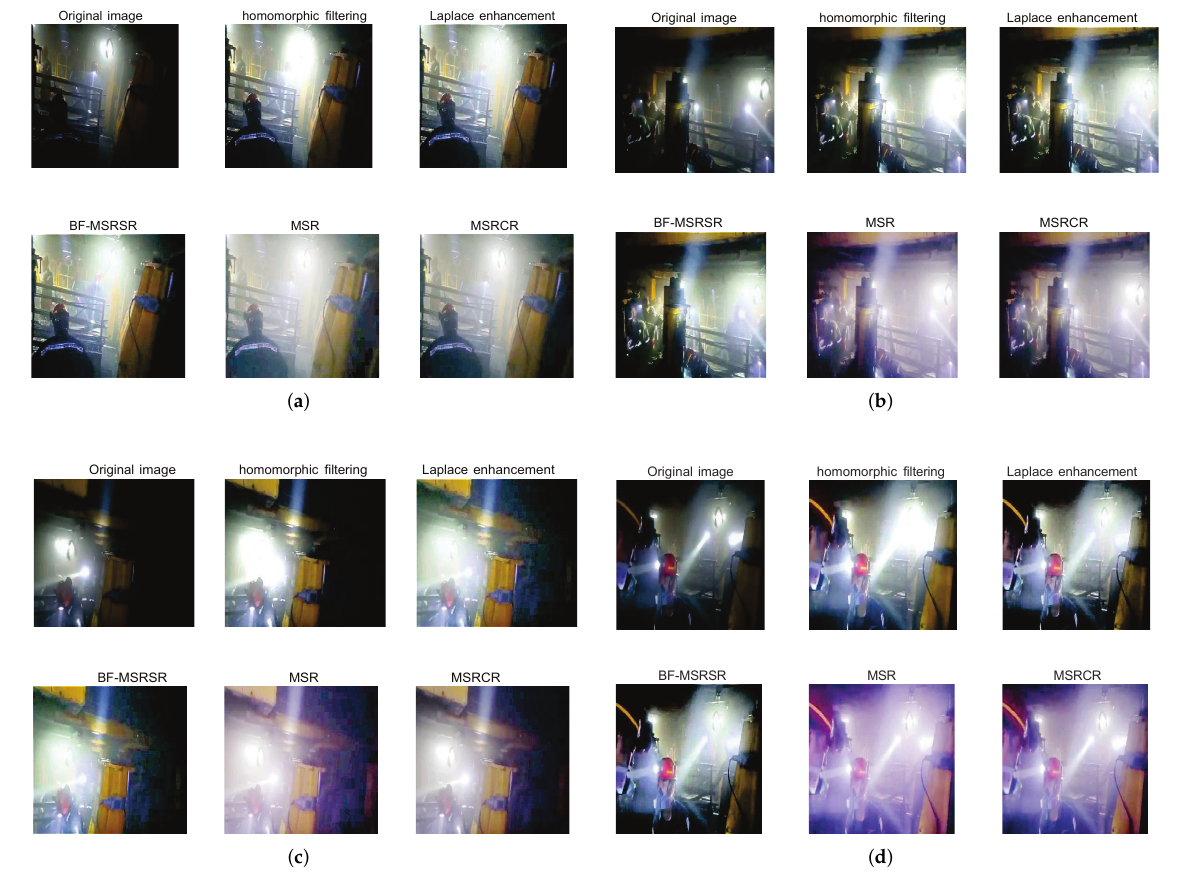
Figure 11. Comparison of video interception image algorithms. ( a ) Video interception image 1 algorithm comparison; ( b ) video interception image 2 algorithm comparison; ( c ) video interception image 3 algorithm comparison; ( d ) video interception image 4 algorithm